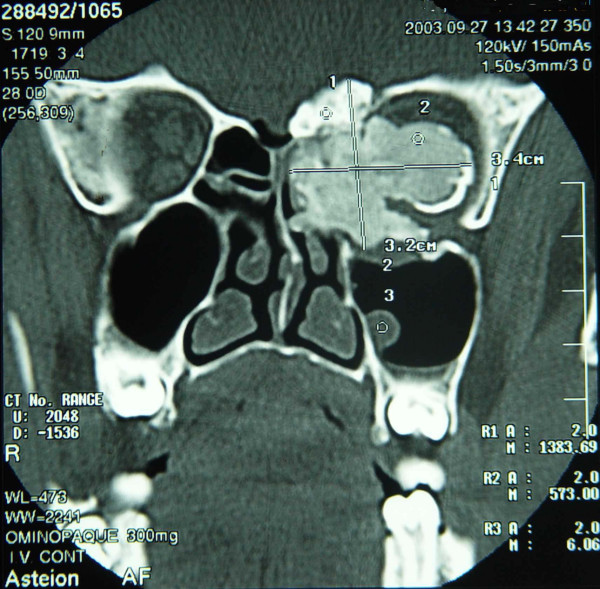
Preoperative CT scan. Preoperative coronal CT scan which shows a large bony tumor arising from the left ethmoid sinus with orbital and intracranial extension.